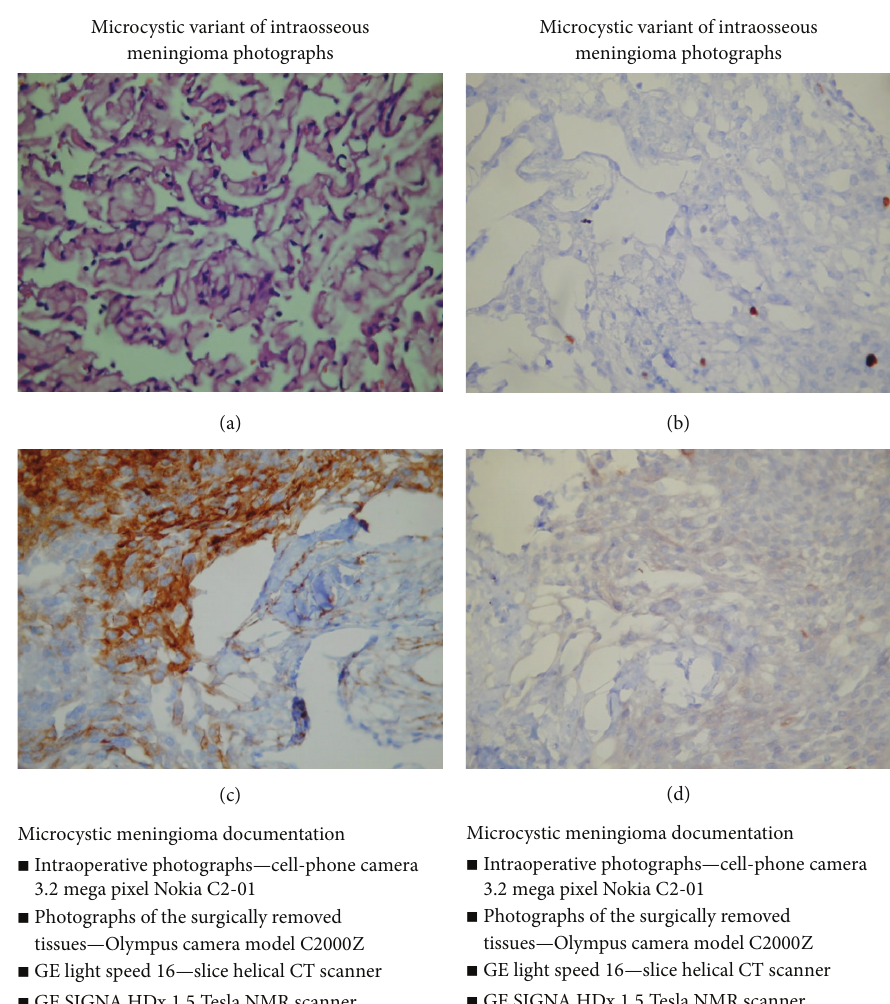
Figure 3: Histopathology: (a) H-E, photomicrograph, original magnification 400x, fragment of the surgically removed tissues, and numerous microcysts containing a pale eosinophilic fluid, surrounded by processes of neoplastic cells; (b) Ki-67, when it is positive in singular cells, it points to very low proliferative activity of the neoplasm, photomicrograph, original magnification 400x, and fragment of the surgically removed tissues; (c) EMA (+), photomicrograph, original magnification 400x, and fragment of the surgically removed tissues; (d) CK (+), photomicrograph, original magnification 400x, and fragment of the surgically removed